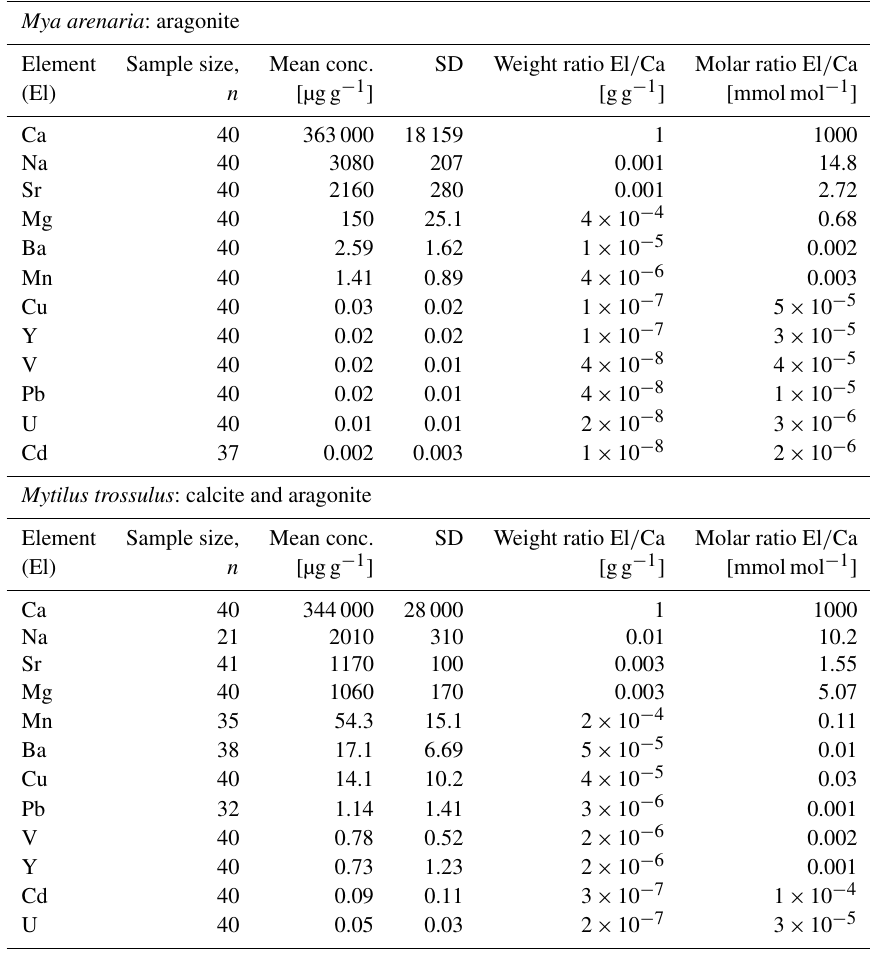
The results of the Kruskal–Wallis nonparametric ANOVA test, which was used to compare the element concentrations between the four size classes in each species, revealed the lack of variability within M. arenaria . The smallest vari- ability was found in L. balthica . Only the concentration of Na ( H = 10 . 586, p = 0 . 014) decreased with shell growth for this clam. The third clam species, C. glaucum , showed high variability in the four trace elements. Shells of